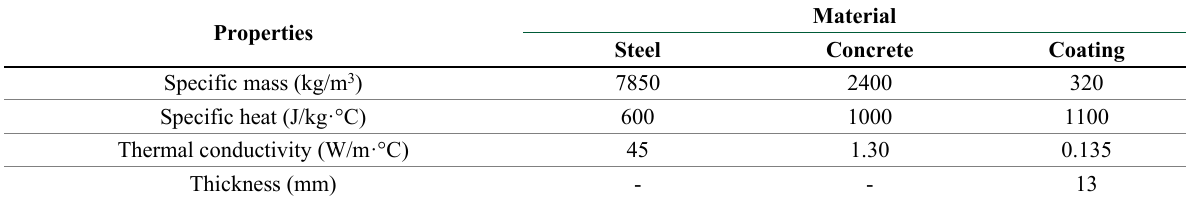
Table 1. Properties of the steel, concrete, and fire protection coating materials.